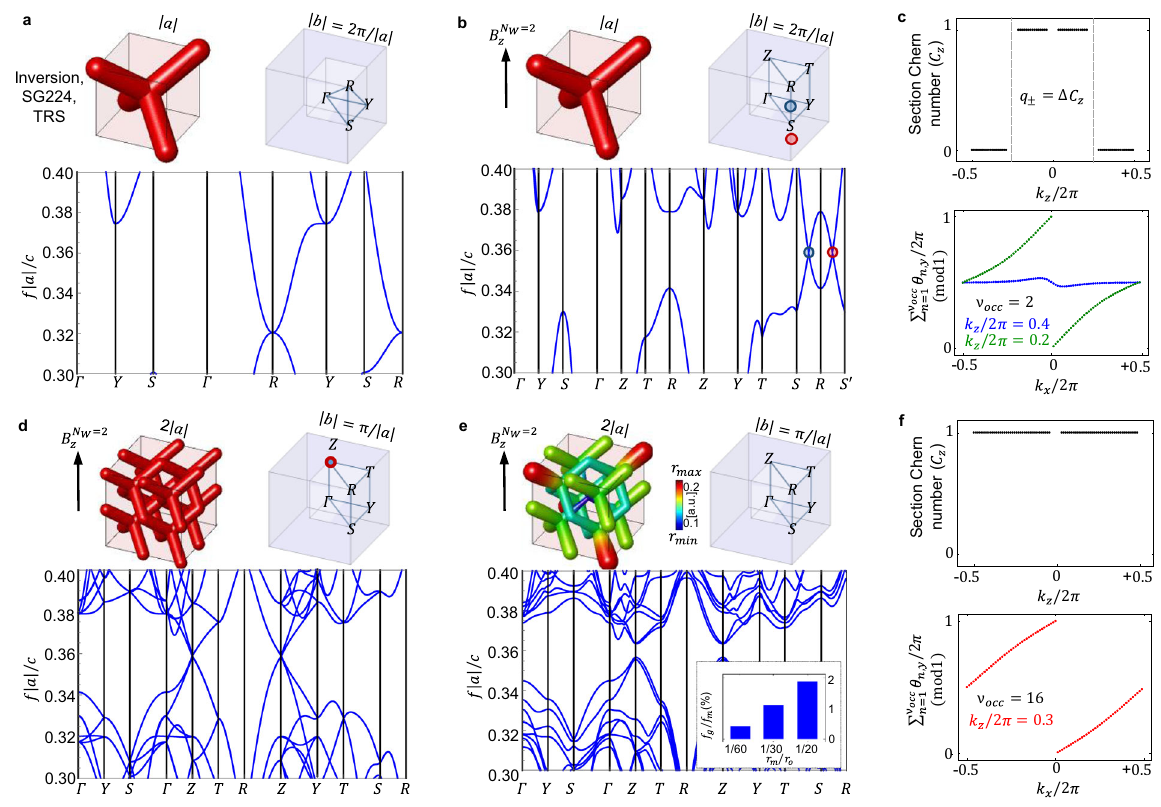
Fig. 1 Photonic 3D CI by cubic supercell modulation at N = N W = 2. Each ( a , b , d , e ) panel shows the crystal unit cell, the irreducible Brillouin zone (IBZ) and the band-structure (BS). Frequencies f are given in reduced units, ∣ a ∣ being the scale invariant lattice parameter and c the speed of light. Sectors ( c ) and ( f ) contain the topological characterization via photonic Wilson loops (WL), in the Weyl semimetallic (WS) phase and in the 3D CI phase, respectively. a Photonic crystal constructed from cylinders of radius r 0 = 0.15 and dielectric constant ε = 16 at TRS. The three lowest photonic modes display a three- fold degeneracy at R and the two lowest bands are fully degenerate in the displayed energy window. b TRS breaking implemented via a gyro-electric response with η N W ¼ 2